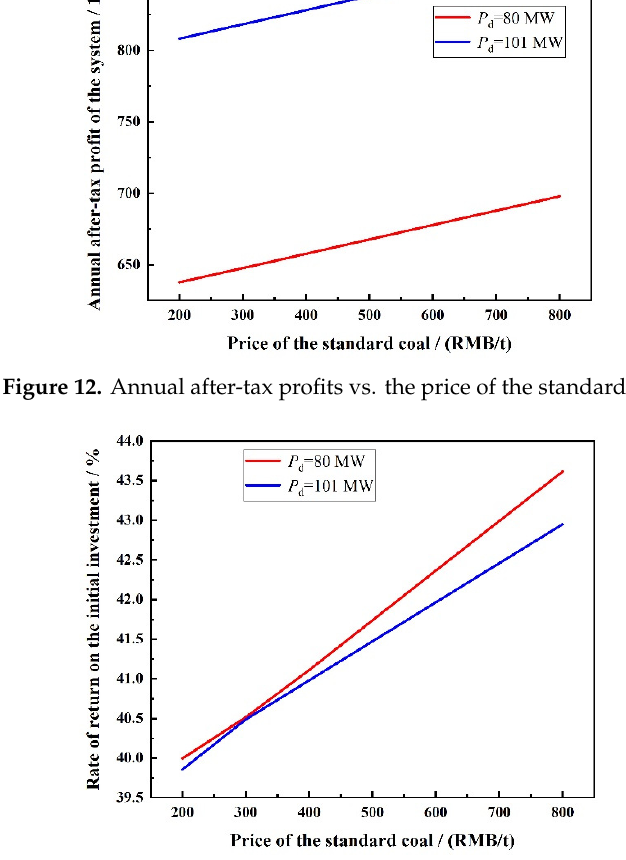
Figure 13. Rate of return on initial investment vs. the price of the standard coal.